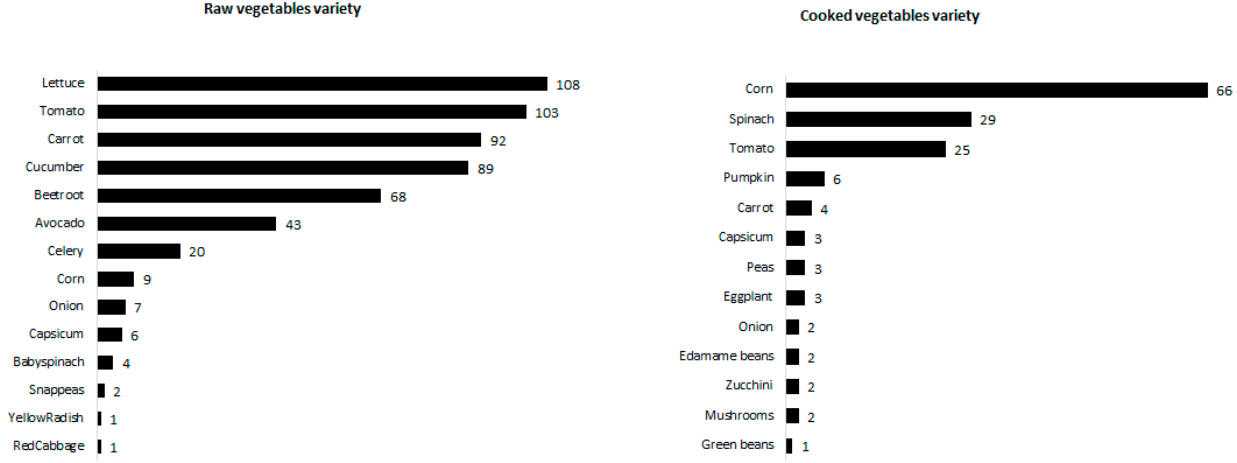
Figure 3. Variety of vegetables (numbers represent the number of menus each vegetable was mentioned). The only statistically significant difference between schools of different SES levels